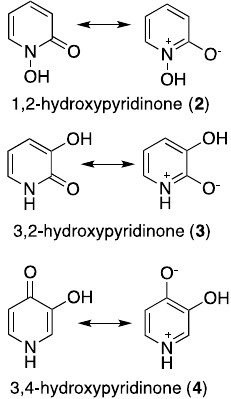
Figure 2. Resonance structures of 1,2-HP, 3,2-HP and 3,4-HP [21]. Table 1. Protonation constants, stepwise stability constants (log K ) and cumulative Fe 3+ stability constants (log β 3 ) for 1,2-HP, 3,2-HP and 3,4-HP.